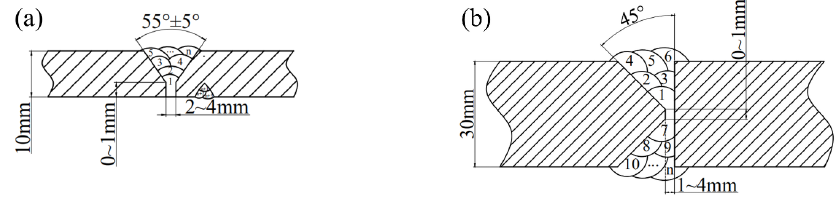
Figure 1. Size of V ‐ type ( a ) and K ‐ type ( b ) groove and weld bead